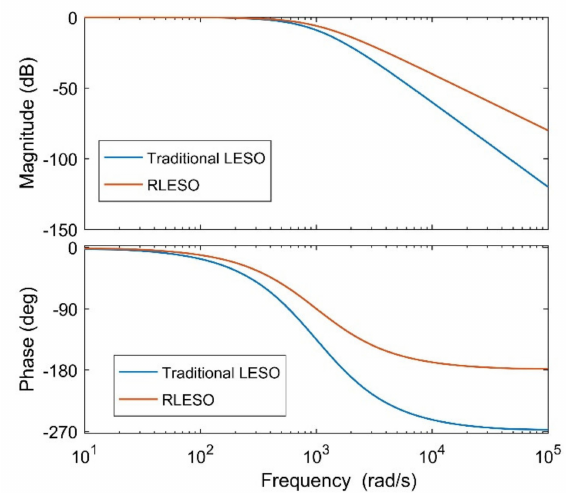
Figure 7. Comparison of the disturbance observation capabilities between traditional LESO and